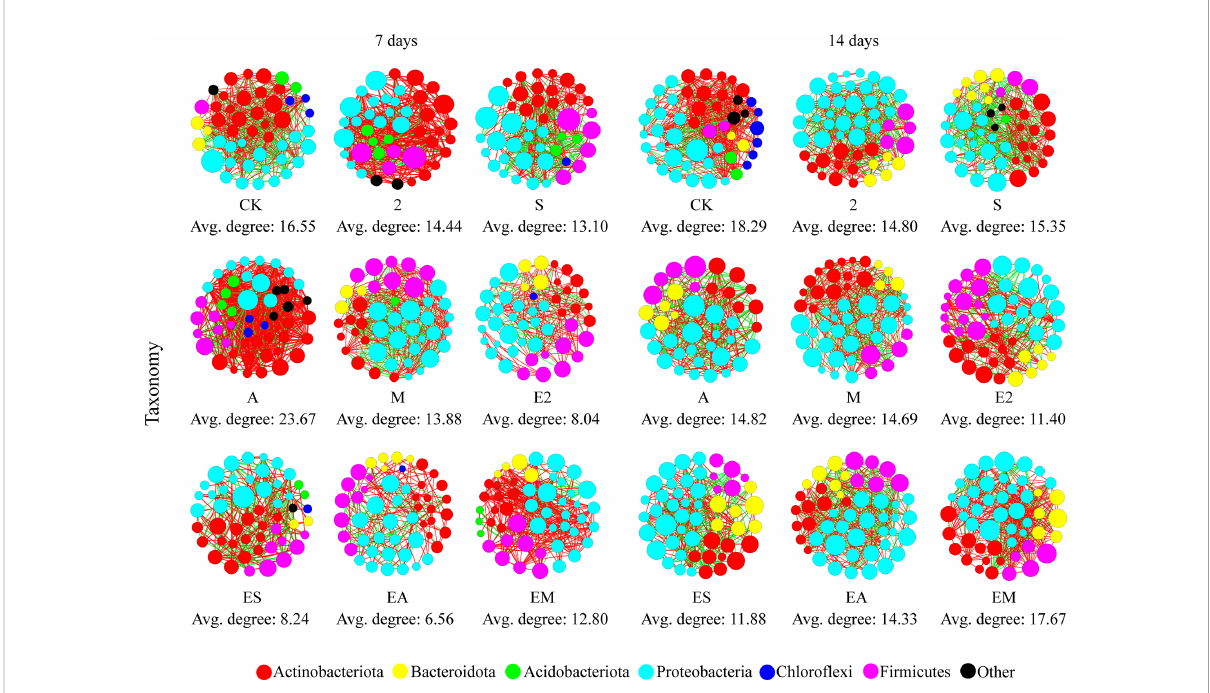
FIGURE 5 Bacterial co-occurrence networks as affected by chemoattractant and chemoattractant-plus-chemotactic strain treatments at 7 and 14 days at the phylum level. Avg, Average degree of